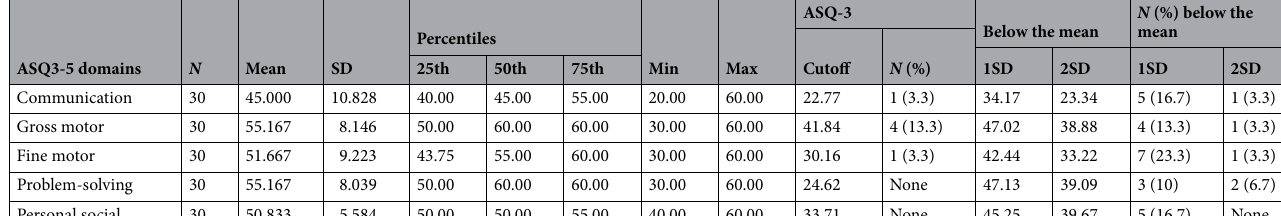
Table 5. Assessment of ASQ-3 at the age of 2 months old. *Below cutoff, the infant needs further assessment with a professional; **Close to the cutoff means the infant needs